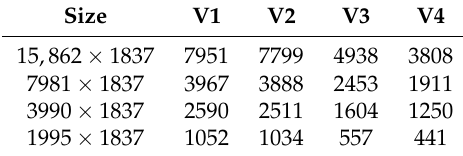
Table 5. Calculation time (ms) of the X-Bragg inversion after different optimization